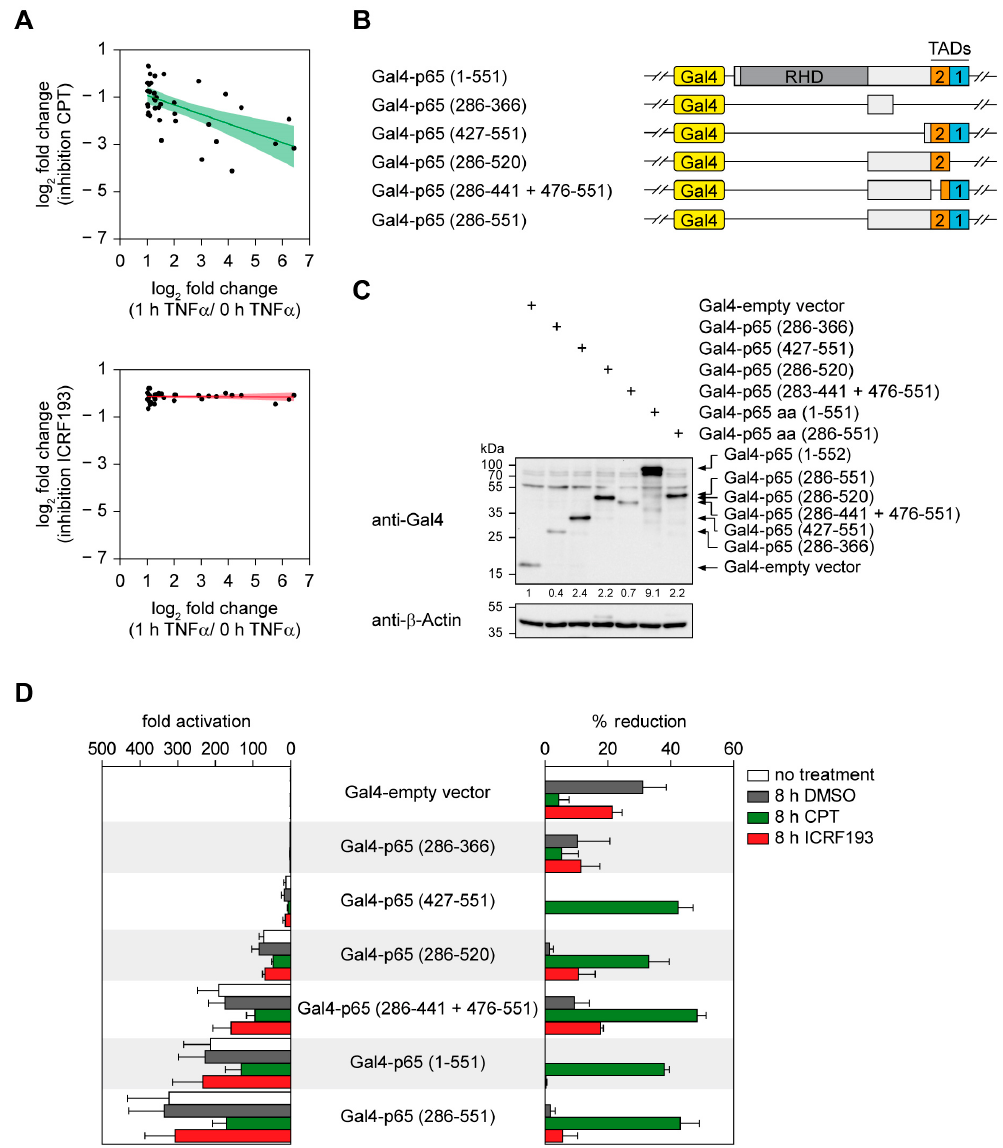
Figure 3 . The contribution of TOP1 for gene expression is not correlated with the strength of gene induction. ( A ) Correlation of the strength of the inhibitory effects by CPT (upper; spearman correlation: − 0.56, coefficients p -value: 2 × 10 − 4 ) or ICRF193 (lower; spearman correlation: − 0.06, coefficients p -value: 0.8668) versus TNF α -induced changes in gene expression. All genes were selected for being TNF α -induced targets (LFC > 1 and ≥ 20 reads). The colored central line represents the linear smooth, the colored area displays the confidence interval around the smooth. ( B ) Schematic visualization of Gal4-p65 constructs containing either full-length p65 (aa 1-551) or truncated forms of p65. The position of the Rel homology domain (RHD) and of the transactivation domains (TADs) are indicated. ( C ) HEK293 cells with a stably integrated Gal4-driven firefly luciferase reporter gene were transfected with the various Gal4 constructs that are visualized in ( B ). Cellular extracts were used to confirm expression of the Gal4-p65 proteins by immunoblotting. The positions of molecular weight markers are indicated, normalized intensity ratios are given for each band. β -Actin was used as housekeeping protein, the whole blots are displayed in Figure S7. ( D ) The cells transfected as described in ( C ) were treated one day later for 8 h with 10 µ M CPT, ICRF193 or DMSO or left untreated. Cell extracts were used to determine the luciferase activity which is displayed either as -fold activation (left) or alternatively as % reduction (right). Error bars show SEMs from three independent